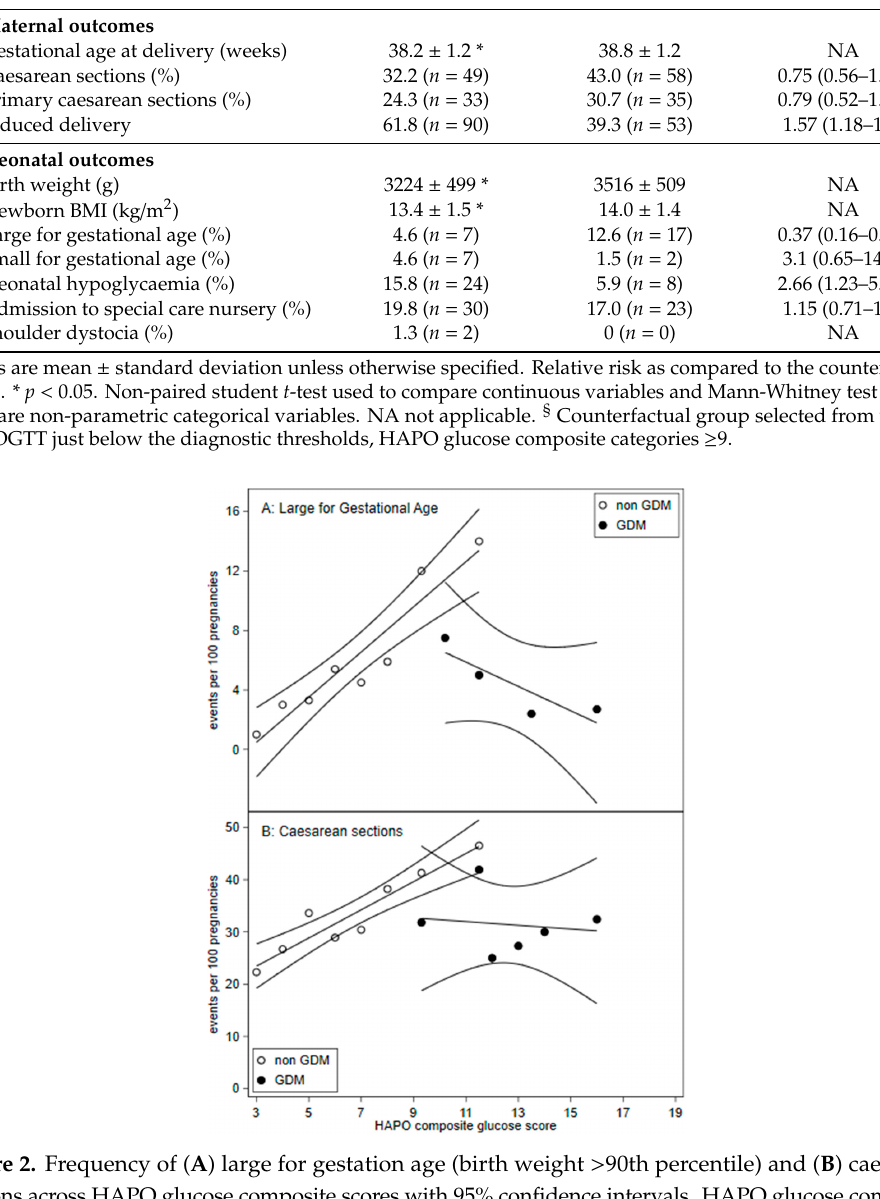
Table 3. Risk of maternal and neonatal outcomes in women treated for GDM compared to the untreated counterfactual group. GDM Treated Relative Risk Counterfactual Group § Outcome n = 152 (95% CI) n = 135 Maternal outcomes Gestational age at delivery (weeks)